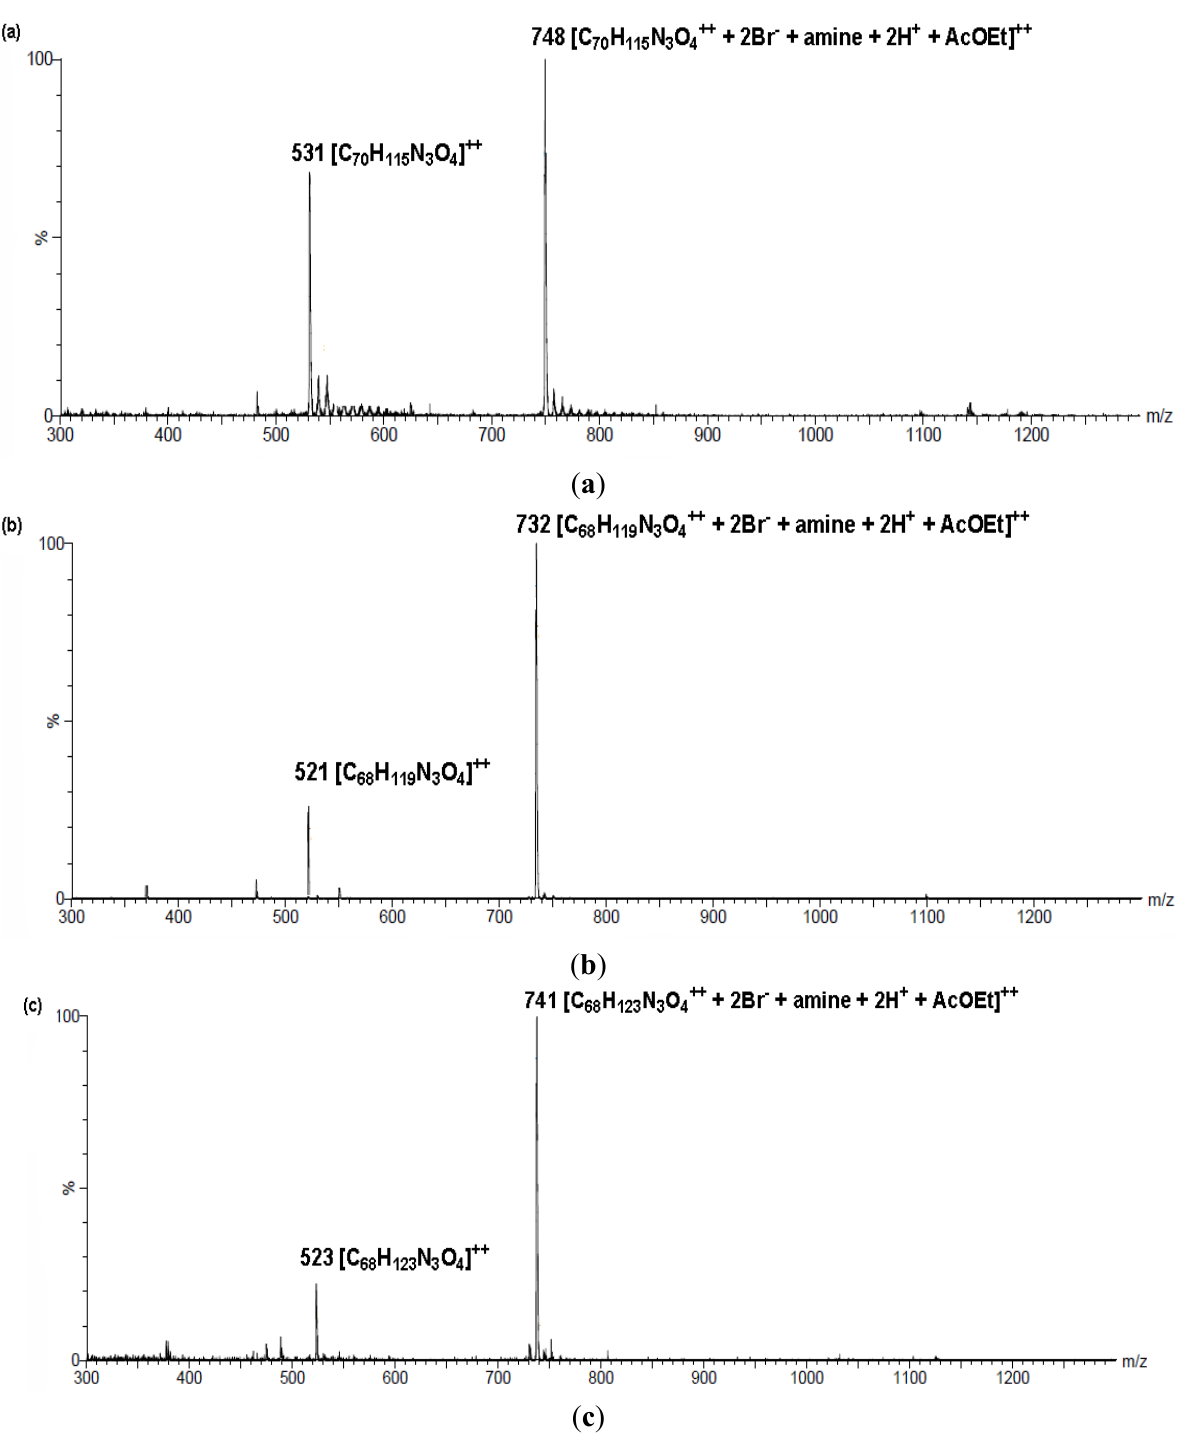
Figure 4. ESI-MS spectrum of compounds 6 ( a ); 9 ( b ); 12 ( c